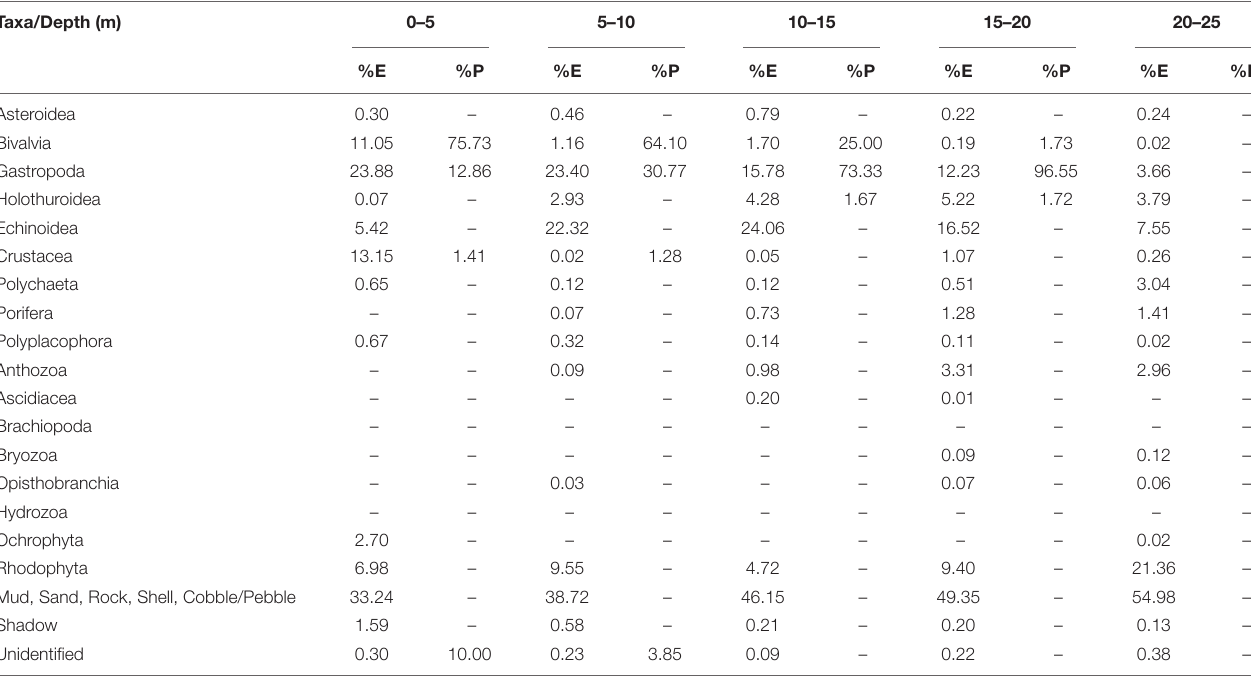
TABLE 1 | Abundance (percent cover) of the potential prey of the sea star Cosmasterias lurida in photo-quadrats at depths down to 25 m (no sea stars were observed below this